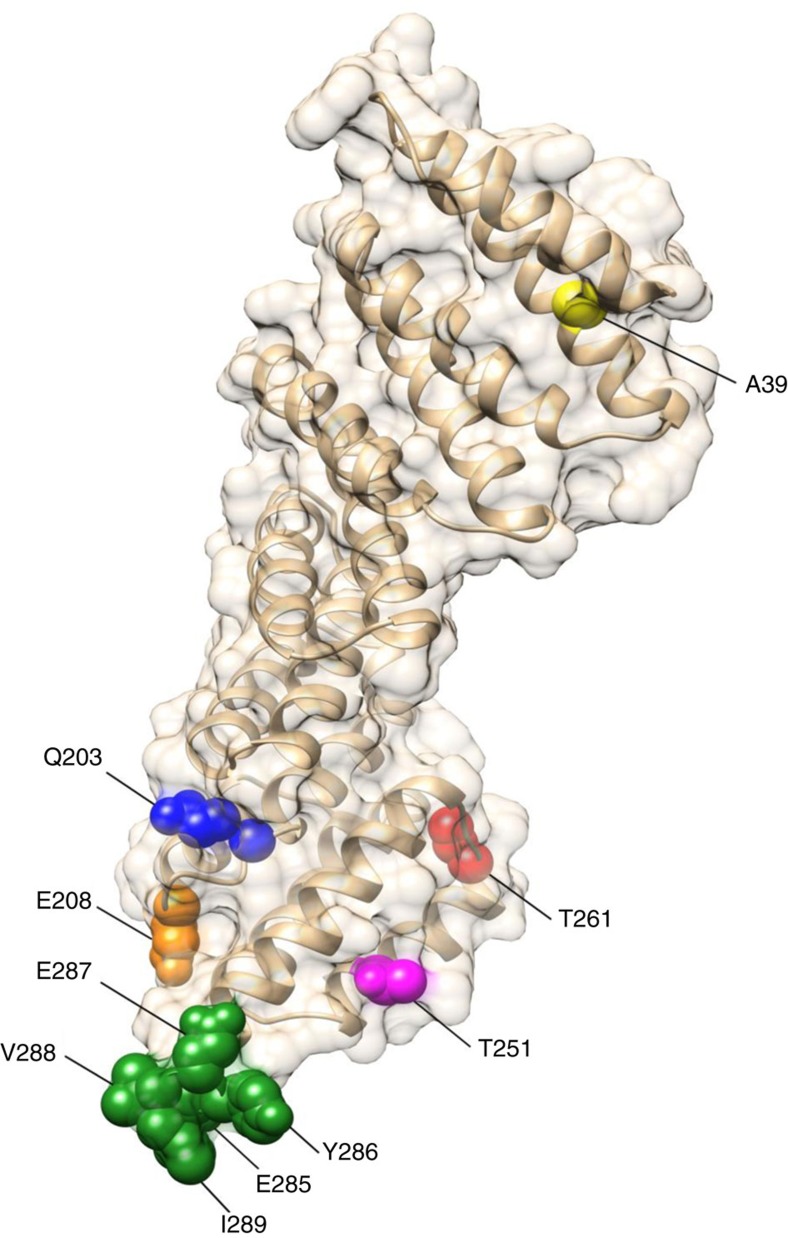
Homology model of the GmSNAP18 from Forrest with mapped residues of identified haplotypes.The C-terminal residues 285-289 (E285, Y286, E287, V288 and I289) vary among all the three GmSNAP18 types; the residue E208 varies in GmSNAP18 Types II and III; the residue Q203 varies in GmSNAP18 Type II; the residue T261 varies only in PI 90763 (from Type I); the residue T251 varies only in PI 209332 (from Type II); and the residue A39 varies only in PI 548316 (from Type II).